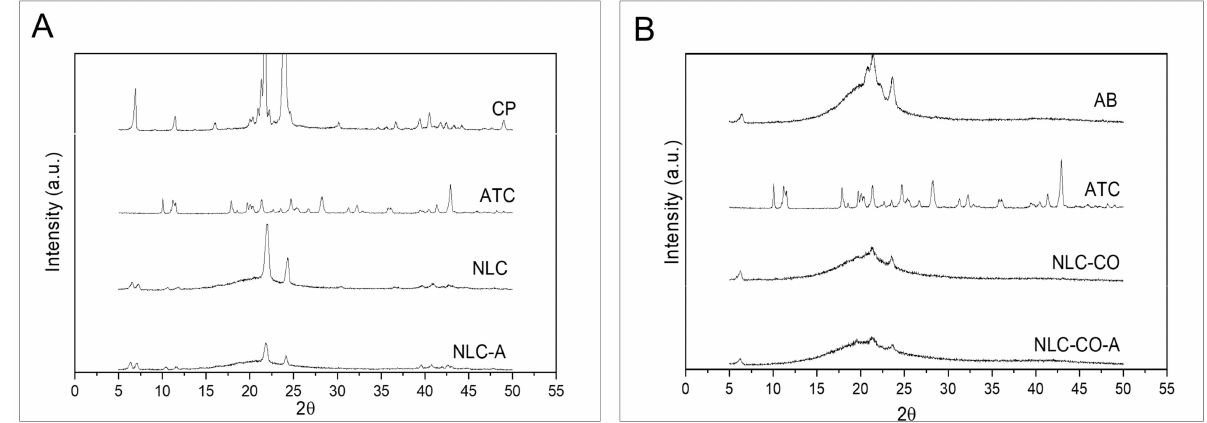
Figure 2. X-ray diffractograms obtained using a Cu-K α source at a 2 ◦ . min − 1 run. ( A ) Pure cetyl palmitate (CP), articaine base (ATC) and synthetic nanostructured lipid carriers without (NLC) and with ATC (NLC-A). ( B ) Pure avocado butter (AB), ATC and natural nanostructured lipid